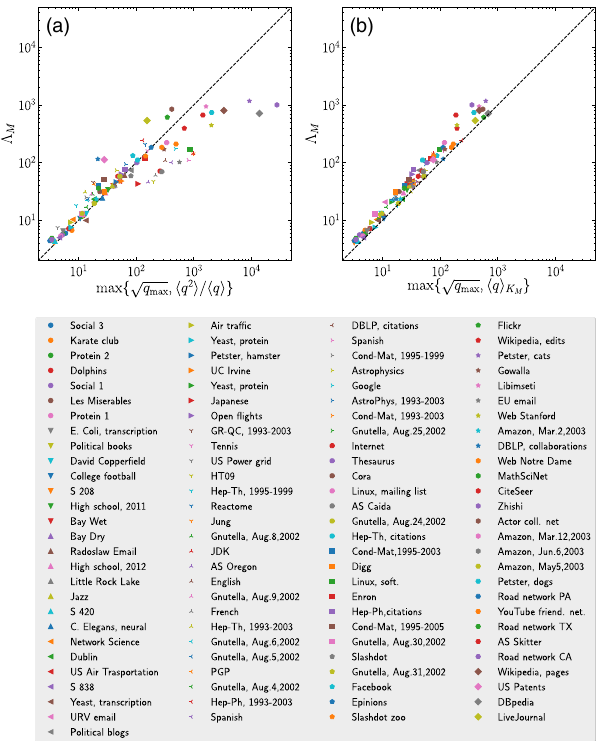
FIG. 2. (a) Largest eigenvalue Λ ffiffiffiffiffiffiffiffiffi p q ; h q 2 i = h q ig computed for 109 different real-world max f max networks. (b) Largest eigenvalue Λ ffiffiffiffiffiffiffiffiffi p ; h q i q max f g computed for the same real-world networks. max K M Networks are ordered by increasing network